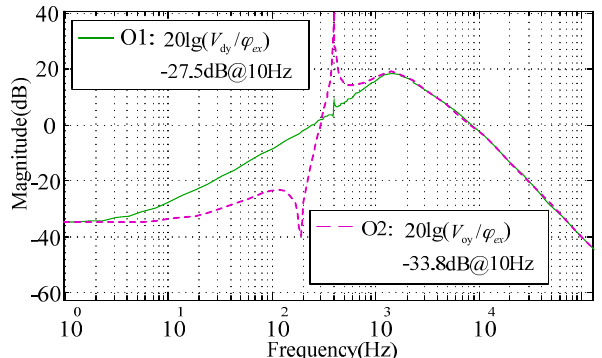
Figure 8. Simulated cross-axis coupling of the gyroscope output responses with (O2) and without (O1) the outer loop decoupling compensator.